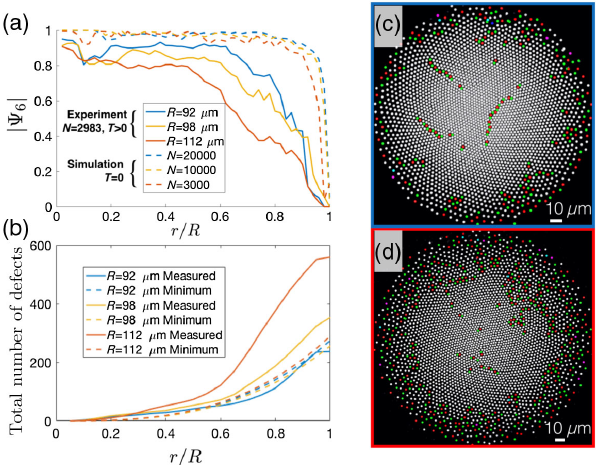
FIG. 6. Inhomogeneous onset of melting. (a) Order parameter variation. Magnitude of orientational order parameter j Ψ 6 j . We find that the onset of melting occurs further into the bulk as the confinement strength is reduced, an effect absent in the simulated zero-temperature configurations. (b) Total number of defects. Total number of defects are compared to the approximate minimum number needed. Here, confinement strength is char- acterized by the resulting crystal size. An experimental crystal representing (c) stronger confinement and (d) weaker confine- ment is